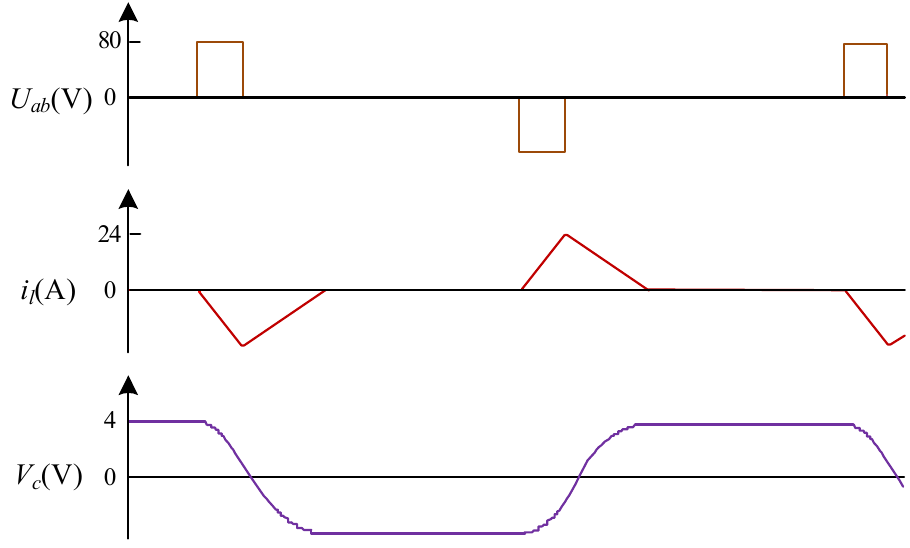
Figure 10. Simulation results at 15% duty ratio.